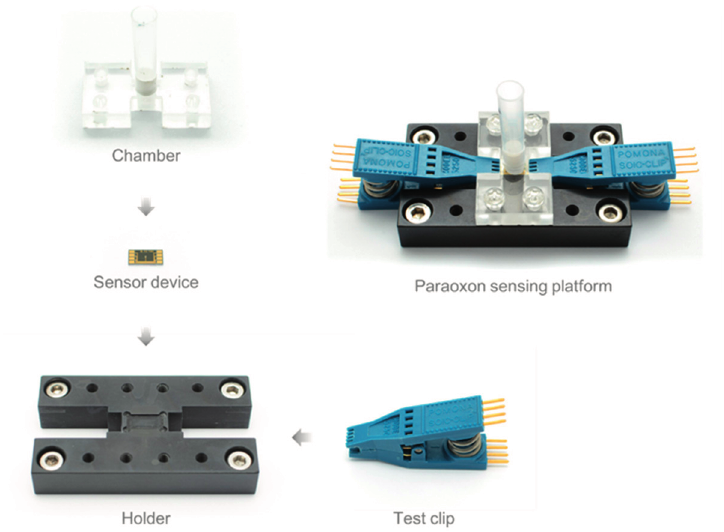
Figure 2. Fabrication process of a platform for a whole-cell OP sensor using E. coli -attached SWNT